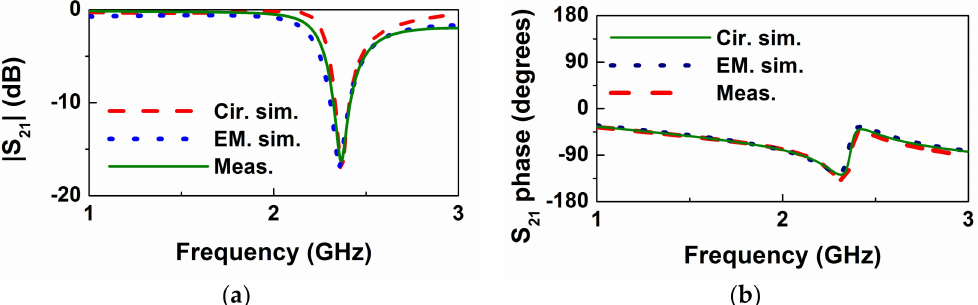
Figure 5. Transmission coefficient of the sensing structure with olive oil in the container. ( a ) Magnitude; ( b ) phase. Phase has been obtained after the reference plane